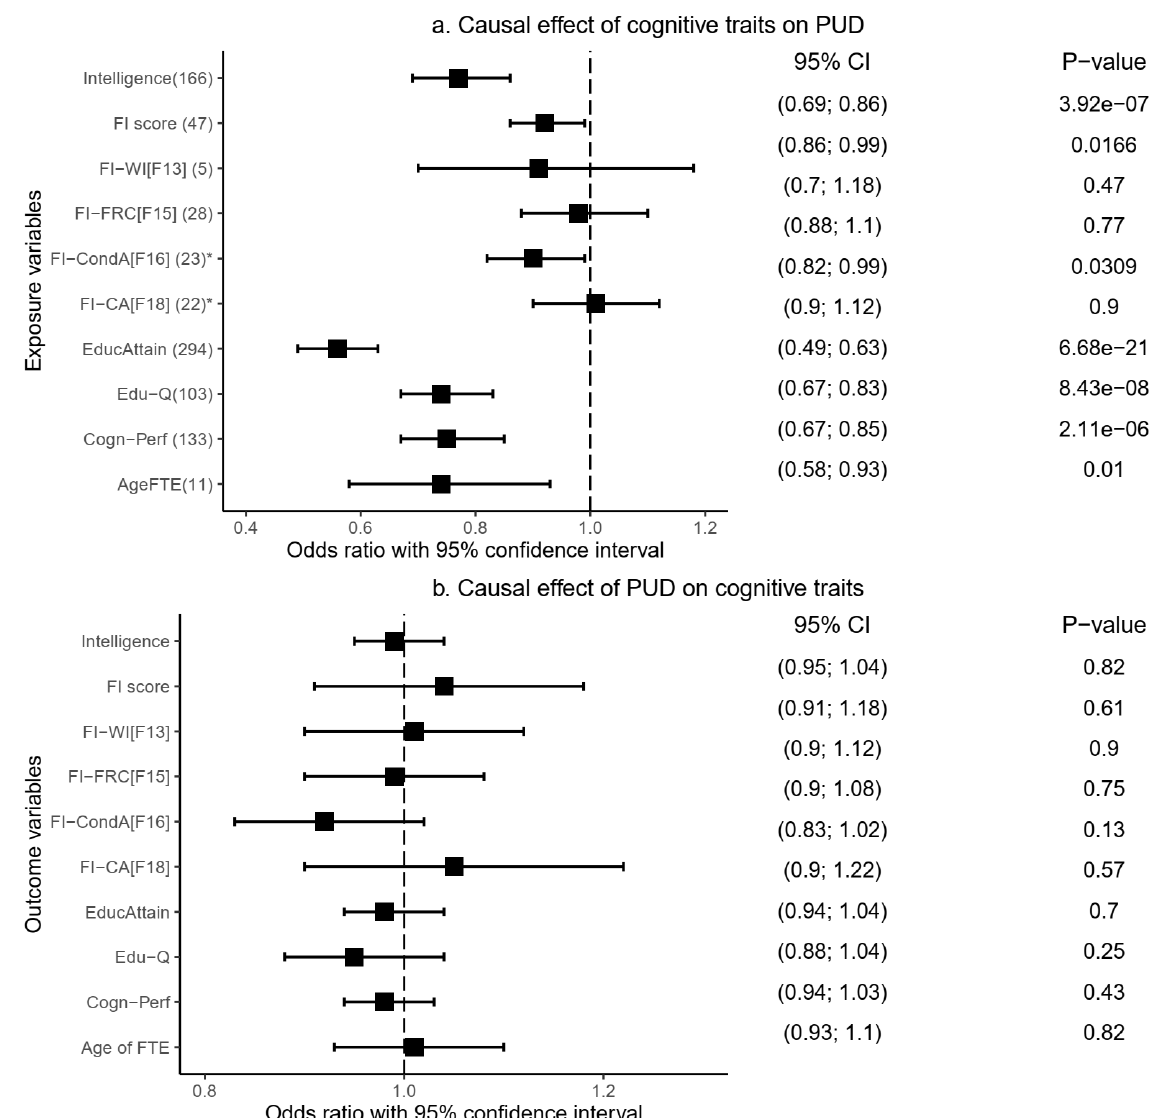
Figure 4. Causal relationship between cognitive traits and PUD based on the IVW MR model. PUD: peptic ulcer disease, Age of FTE: age completed full-time education, FI-CA[F18]: fluid intelligence-chained arithmetic, FI-CondA[F16]: fluid intelligence-conditional arithmetic, FI-FRC[F15]: fluid intelligence-family relationship calculation, FI-WI[F13]: fluid intelligence-word interpolation, Cogn-Perf: cognitive performance, EducAttain: educational attainment, * instrumental variables selected at p snp < 1 × 10 − 5 , ivw: inverse variance weighted, MR: Mendelian randomisation.